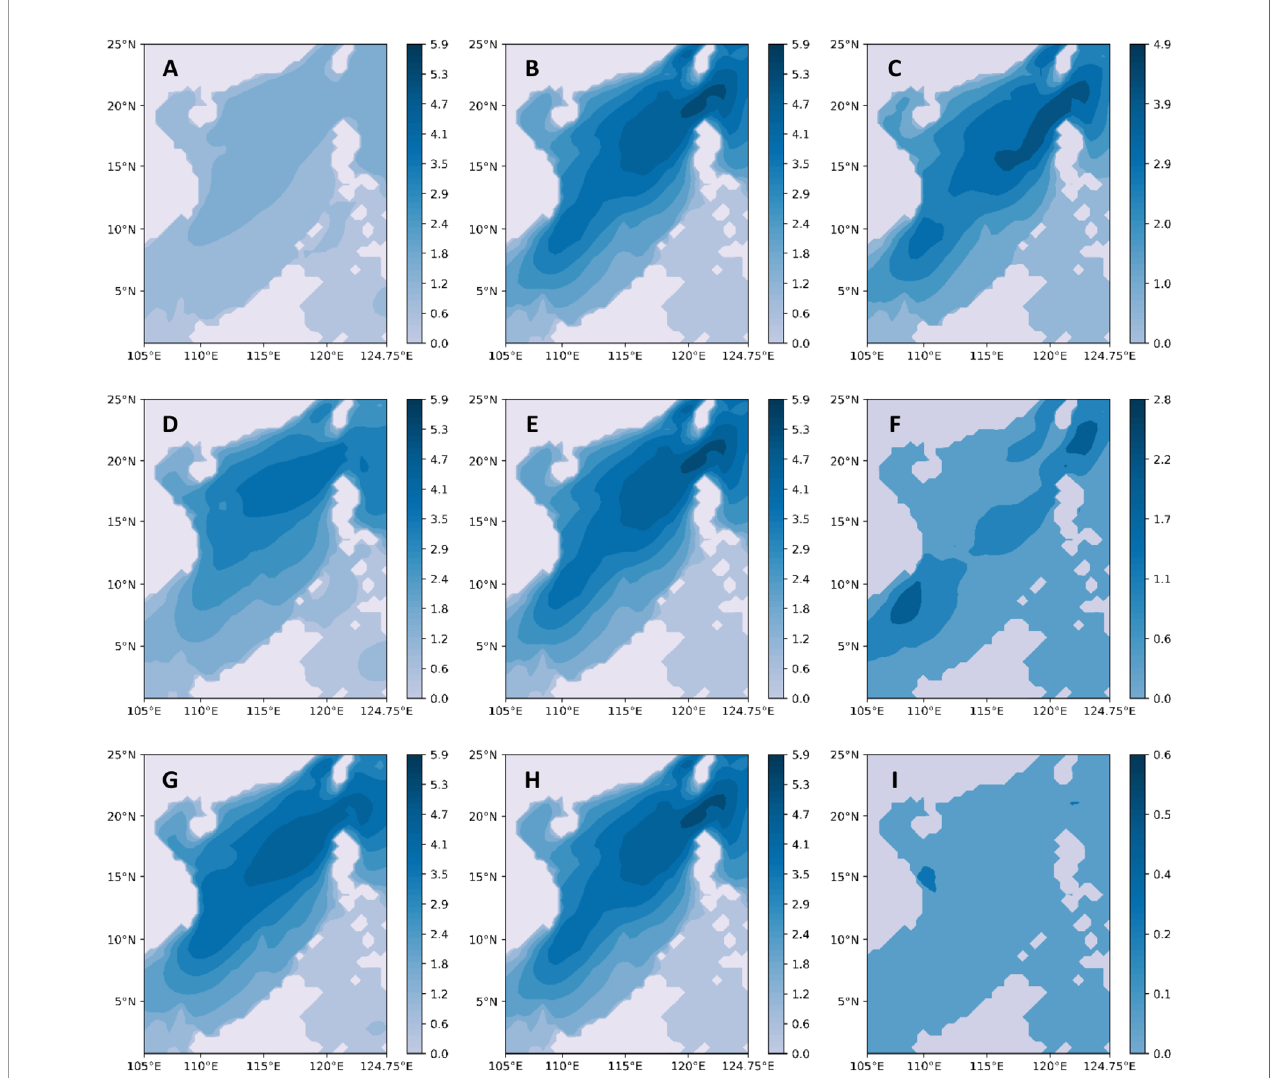
FIGURE 6 | Continuous prediction for one-hour prediction. (A – C) are the prediction results of the CNN model, the ERA5 data results, and the prediction errors, respectively. (D – F) are the prediction results of the CNN + Bi-LSTM model, the ERA5 data results, and the prediction errors, respectively. (G – I) are CBA-Net model prediction results, ERA5 data results, and prediction errors, respectively.